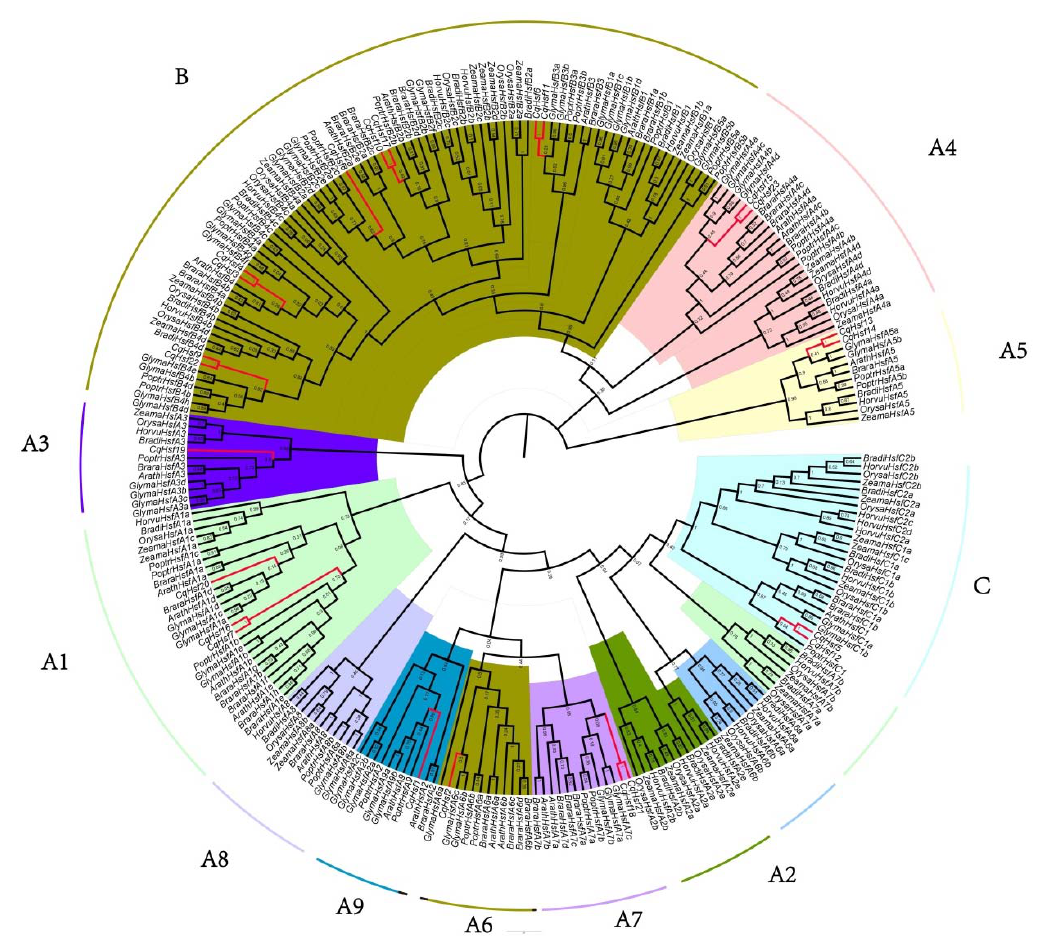
Figure 1. Phylogenetic relationship of HSf proteins in quinoa with eight other species.